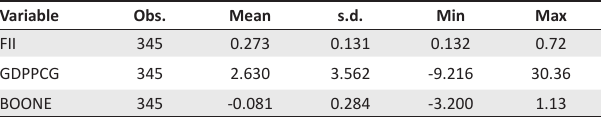
TABLE 2: Descriptive statistics.